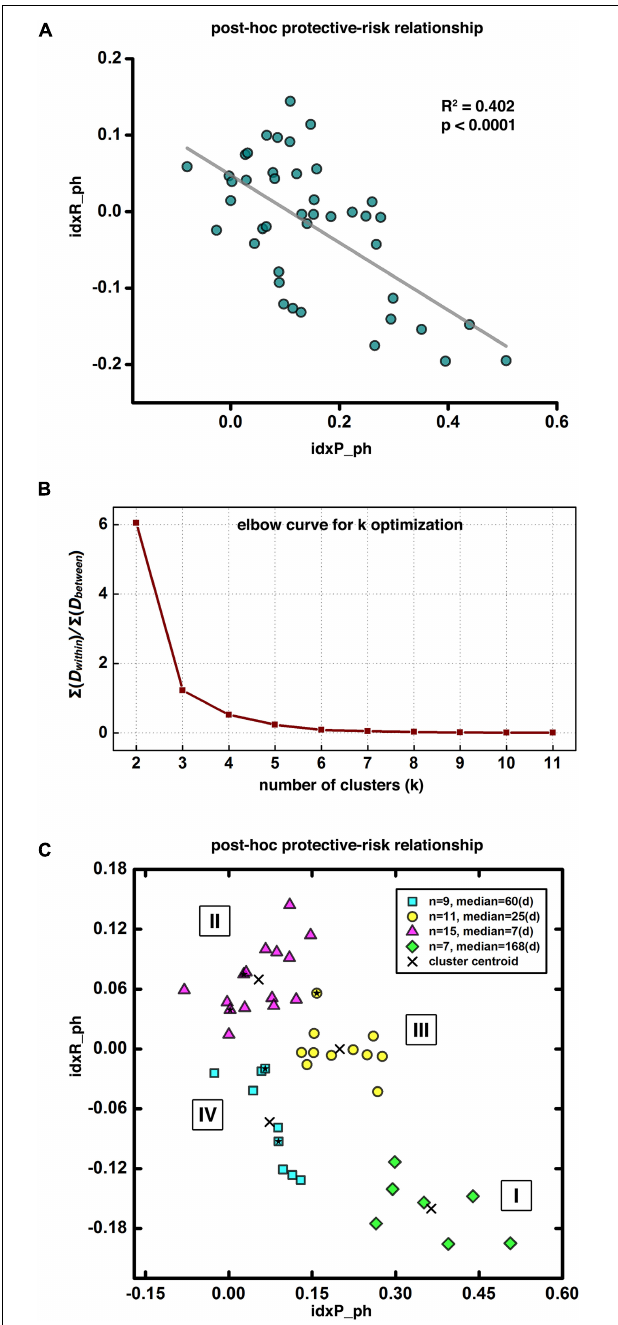
FIGURE 5 | Post-hoc results and disease subtyping. Panel (A) shows significant negative correlation between the post-hoc protective and risk indices. Panel (B) demonstrates the “elbow curve” for cluster number selection in clustering analysis for disease subtyping. Panel (C) illustrates four potential subtypes of cocaine dependent participants as indicated by our clustering result, Subtype I at the bottom-right corner with longest abstinent days (green diamonds), Subtype II at the top-left corner with the shortest days till relapse (magenta triangles), and Subtypes III and IV in-between with moderated days till relapse (yellow circles and cyan squares). The five solid stars within the corresponding symbol shapes label the five female participants in current demonstrative